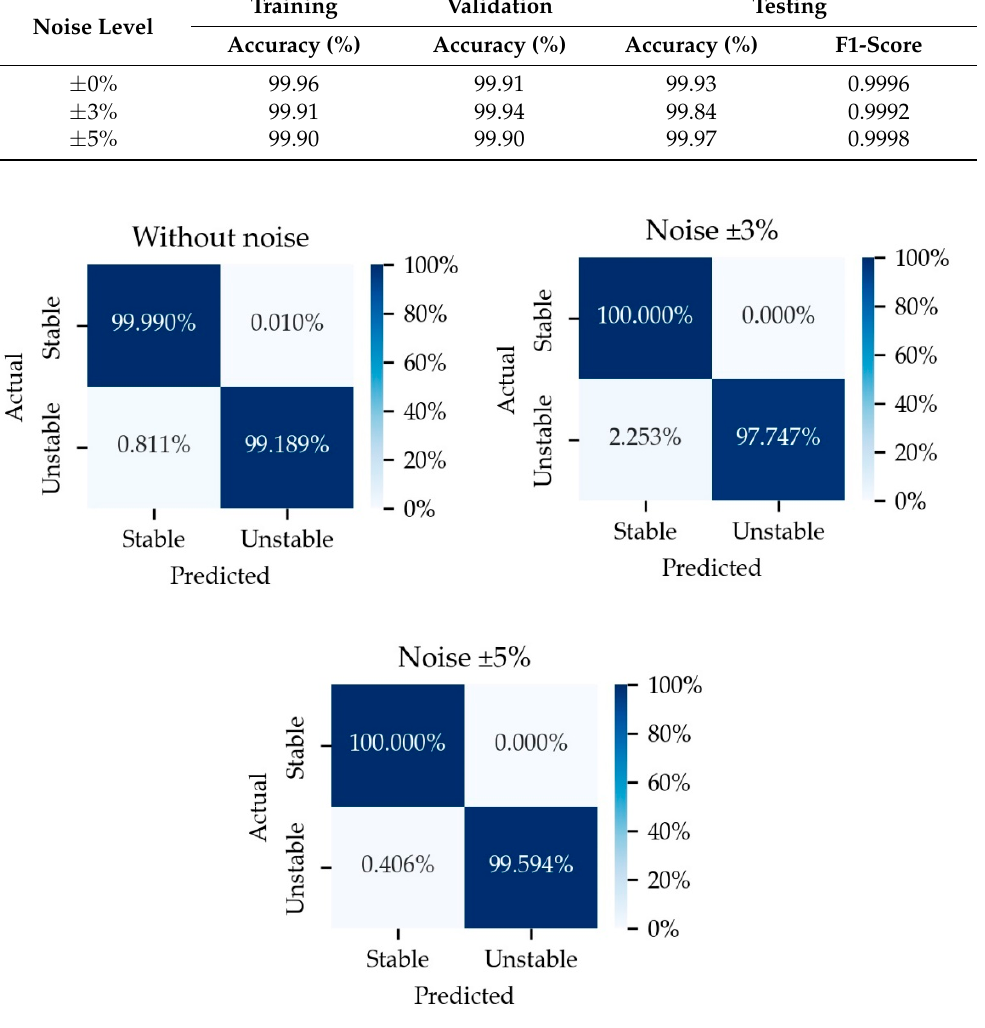
Figure 9. Recapitulation of normalized confusion matrix for the effect of noisy data.